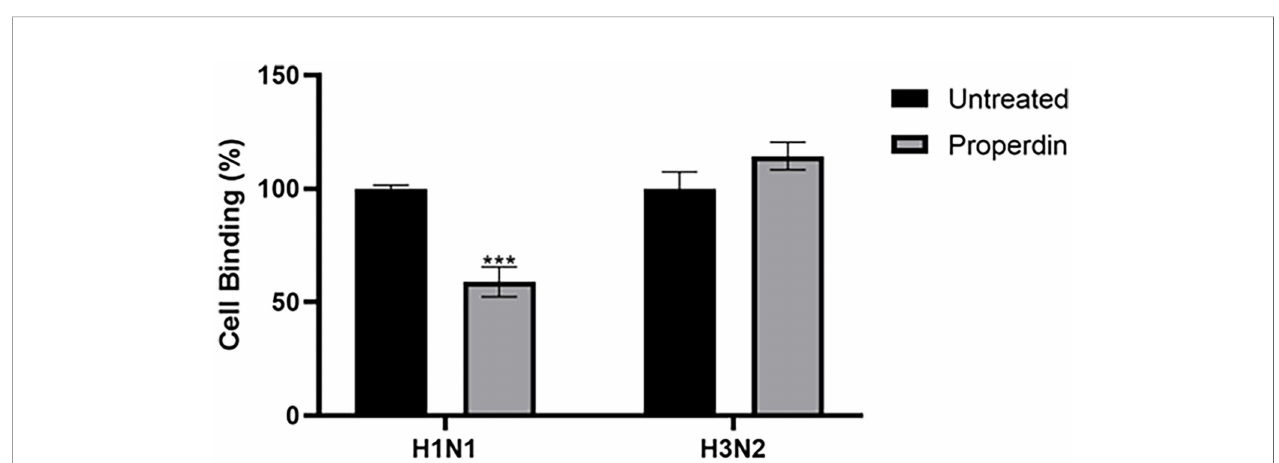
FIGURE 8 | Cell binding assay to show properdin treatment inhibits IAV infection by restricting H1N1 or H3N2 viral particles binding to the cell-surface receptor. A549 (1 × 10 5 cells/ml) cells were infected with H1N1 or H3N2 viral particles pre-incubated with or without properdin (20 µg/ml), followed by incubating at 37°C for 2h. After removing unbound protein and viral particles, the wells were fi xed with 1% v/v paraformaldehyde for 1 min and probed with corresponding primary antibodies; monoclonal anti-in fl uenza virus H1 or polyclonal anti-in fl uenza virus H3 antibodies (1:5000). Three independent experiments were carried out in triplicates, and error bars express as ± SEM. Signi fi cance was determined using the two-way ANOVA test (***p < 0.001) (n =